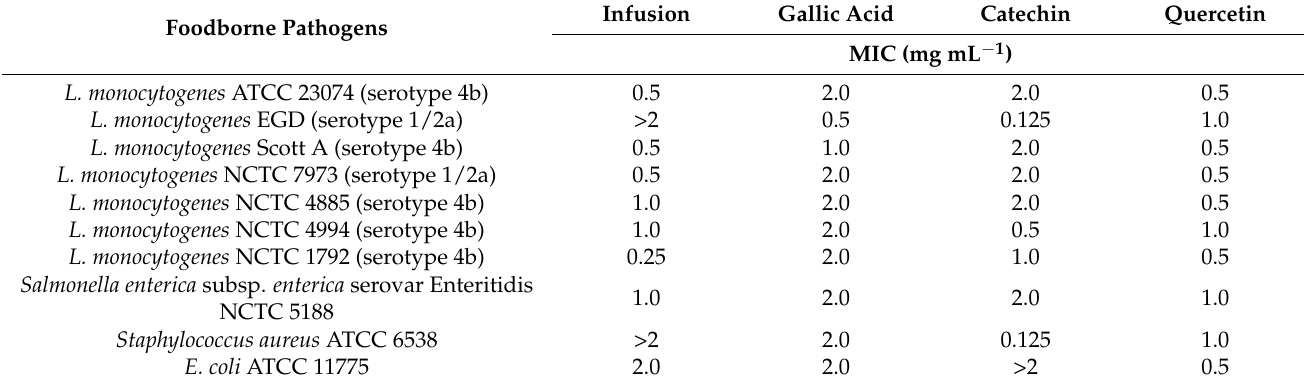
Table 5. Minimum Inhibitory Concentration (MIC) values of grape pomace infusion, gallic acid, catechin and quercetin against foodborne